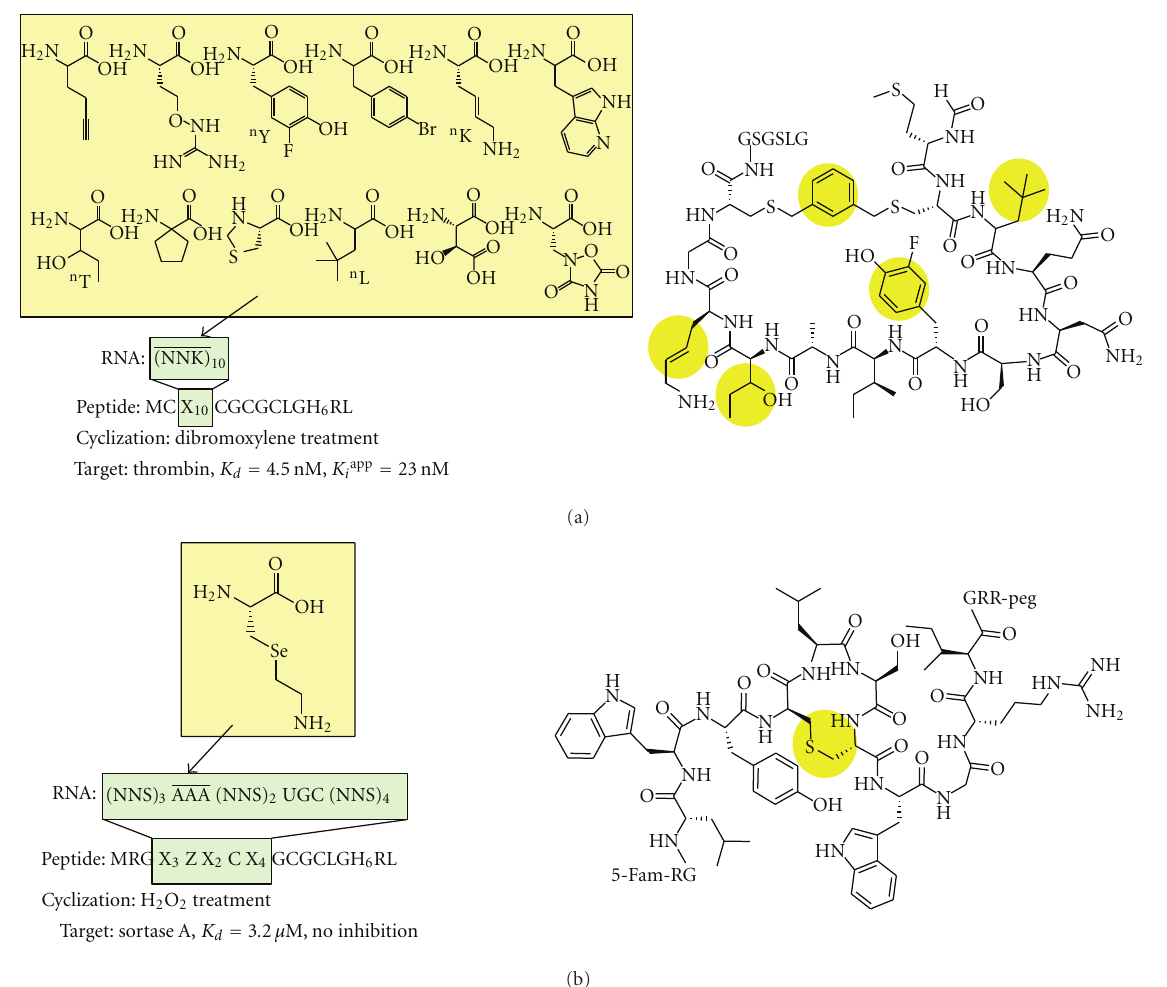
Figure 5: Selection of nonstandard peptides from libraries generated by aaRS-based genetic code reprogramming. Nonproteinogenic amino acids were charged onto tRNA by aaRS misacylation. The non-standard peptide libraries were expressed in a reconstituted cell- free translation system in the mRNA display format. (a) Selection of non-standard peptides from libraries containing 12 di ff erent nonproteinogenic amino acids (12 proteinogenic amino acid analogs). The nonproteinogenic amino acids were reassigned to NNK codons. The peptides were cyclized by the addition of 1,3-di(bromomethyl)benzene to react with the sulfhydryl groups on the two cysteine residues of the peptides. The cyclic peptide library, containing 10 random residues, was used for the selection of thrombin inhibitors. (b) Selection of sortase A binding lantipeptides. L-4-selenalysine was reassigned to the AAA codon. The L-4-selenalysine residue was oxidized and converted to dehydroalanine, which was used for cyclization of the peptide. The cyclic peptide library, containing nine random residues, was used for